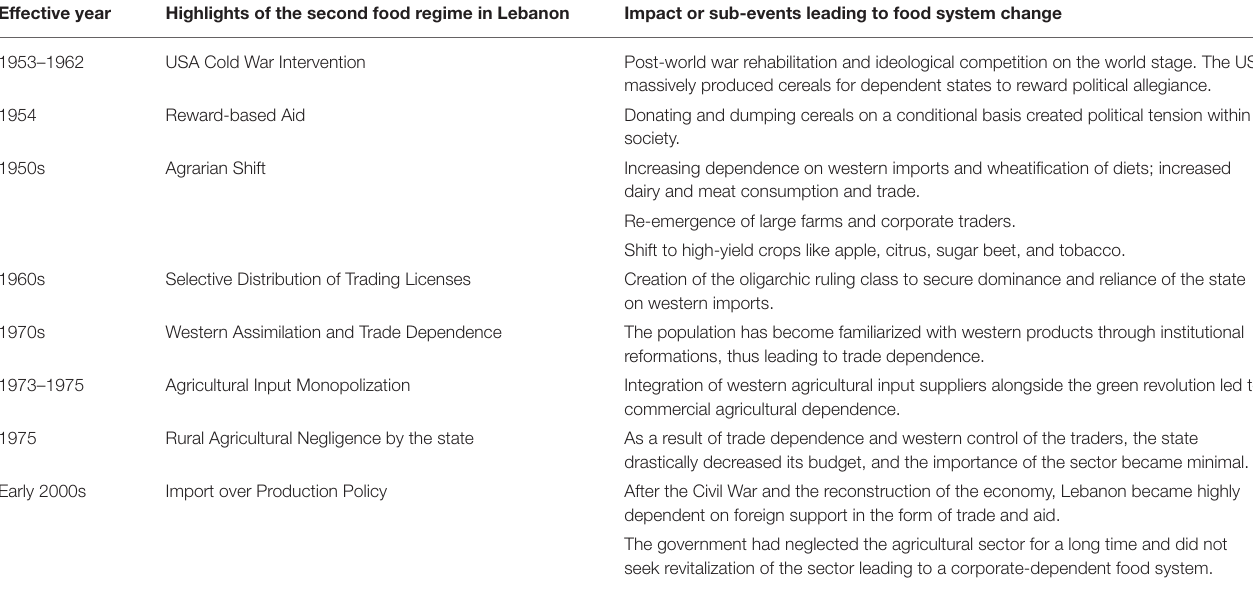
TABLE 2 | Overview of the second food regime in